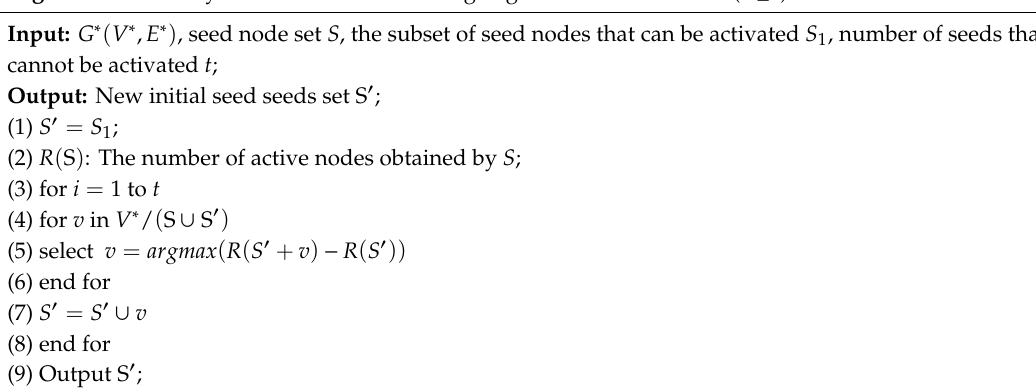
Algorithm 2. Greedy-based Substitutes Mining Algorithm for SMMNIM